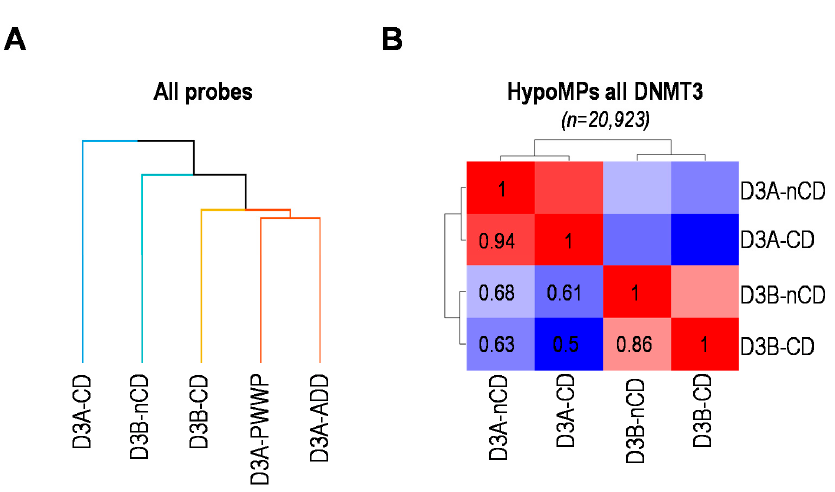
Figure 3. Convergent and distinguishing methylomes in patients with catalytic or non-catalytic mutations in DNMT3 enzymes. ( A ) Clustering of subgroups of patients with catalytic (CD) or non-catalytic (nCD, i.e., PWWP or ADD) mutations in DNMT3A or DNMT3B based on β -values of all the HM450K probes analyzed ( n = 361,359). Groups are highlighted by different branch colors. ( B ) Pairwise Pearson correlation between patients with catalytic (CD) or non-catalytic (nCD) mutations in DNMT3A or DNMT3B based on the union of all HypoMPs in DNMT3 mutants. The colors of the heat map range from high correlation in red to low correlation in blue. Pairwise indexes are indicated on the heat map.